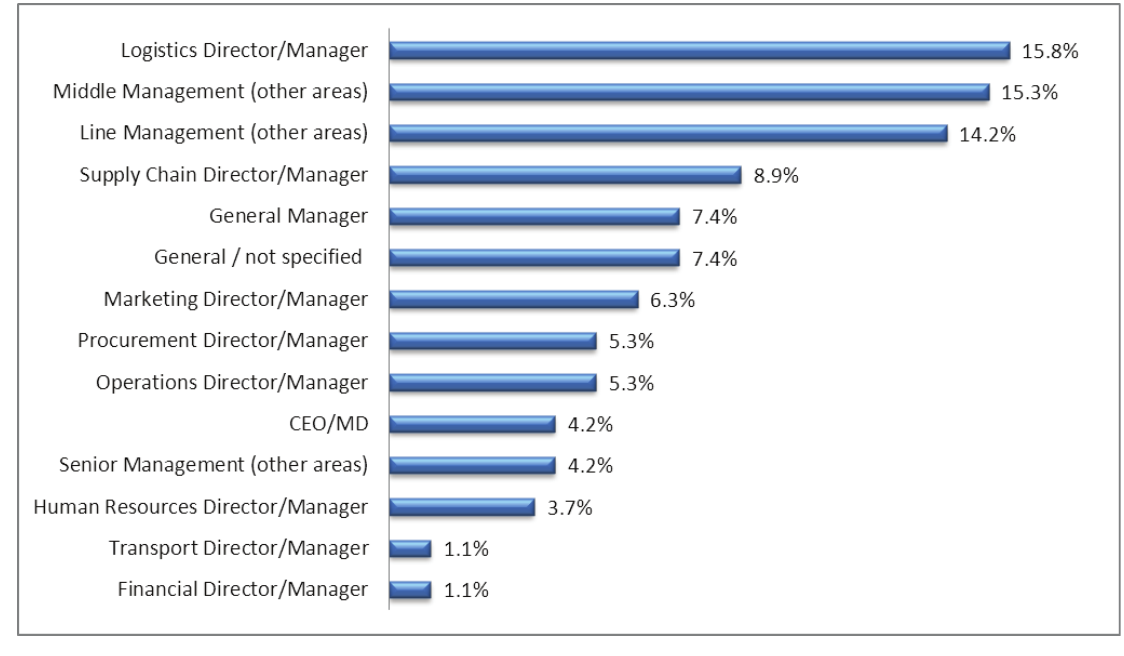
Figure 2: Respondents’ position in organisation Table 2: Mean rating of proposed skills groups